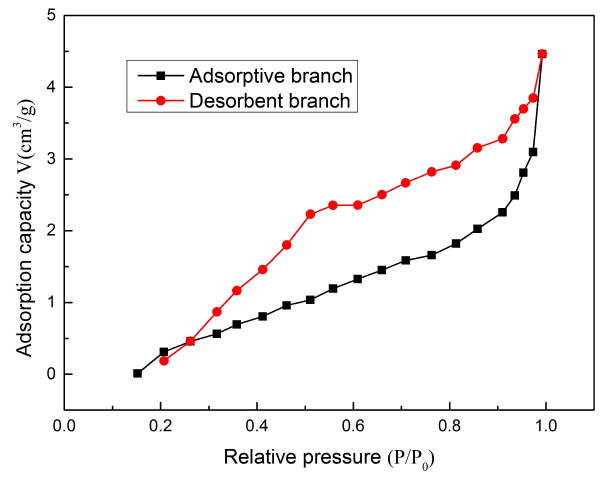
Figure 10: BET images of DAMCC/CMCS foam